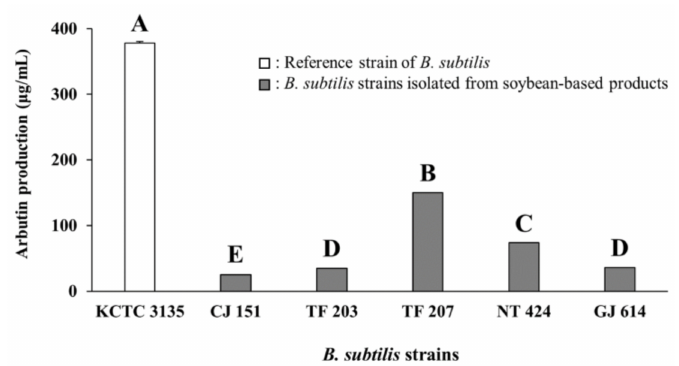
Figure 1. Arbutin production by various B. subtilis strains in assay media. KCTC 3135: Reference strain of B. subtilis , CJ 151: B. subtilis strain isolated from Chunjang , TF 203: B. subtilis strain isolated from tofu, TF 207: B. subtilis strain isolated from tofu, NT 424: B. subtilis strain isolated from Natto , GJ 614: B. subtilis strain isolated from Gochujang. Values of bars with di ff erent letters (A–E) are significantly di ff erent ( p < 0.05). Error bars indicate standard deviations determined from triplicate experiments. Some Bacillus spp. such as B. subtilis , B. licheniformis , B. coagulans , and B. pumilus which